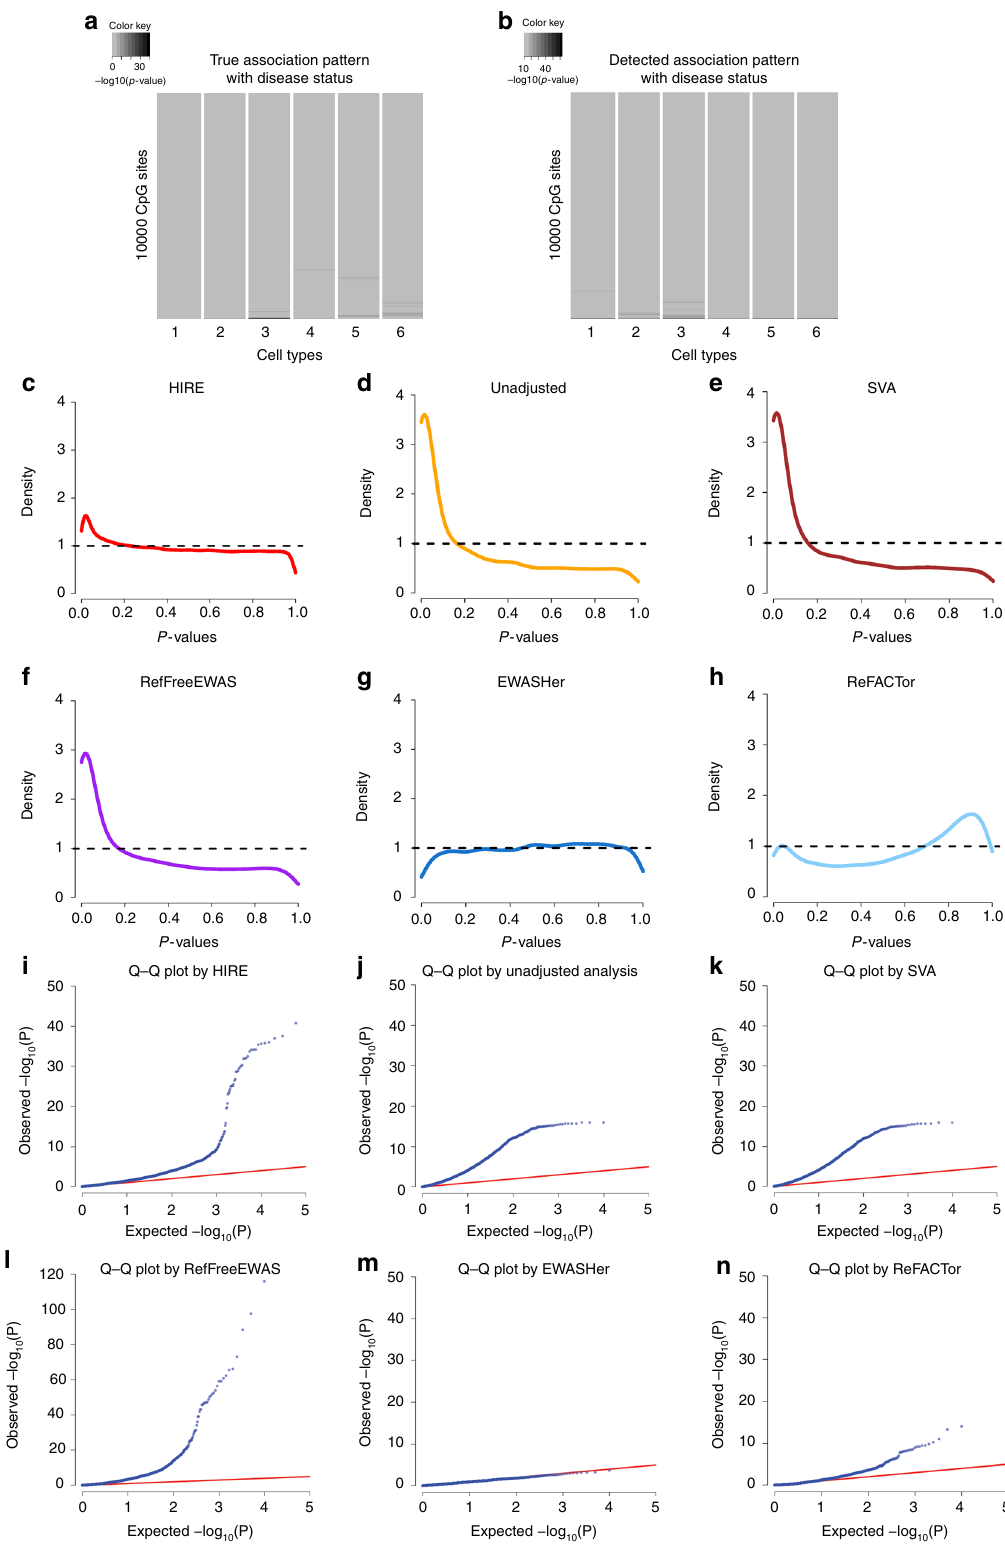
Fig. 3 Application of HIRE and commonly used methods to two real methylation datasets: RA and GALA II. Source data are provided as a Source Data fi le. a Cell-type-specic association pattern with RA status detected by HIRE in the RA dataset. Darkness represents the − log10(p − value). b Cell-type-specic association pattern with gender detected by HIRE in the GALA II dataset. The darkness represents the − log10(p − value). c – h The p-value density plots for association with RA status in the RA dataset for c HIRE, d unadjusted analysis, e SVA, f RefFreeEWAS, g EWASHer, and h ReFACTor. i - n Q-Q plots for association with RA status in the RA dataset for i HIRE, j unadjusted analysis, k SVA, l RefFreeEWAS, m EWASHer, and n